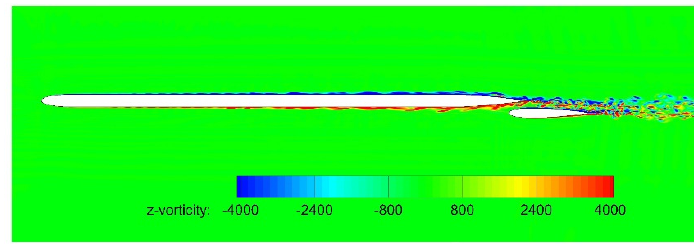
Figure 5. z-direction vorticity contours.